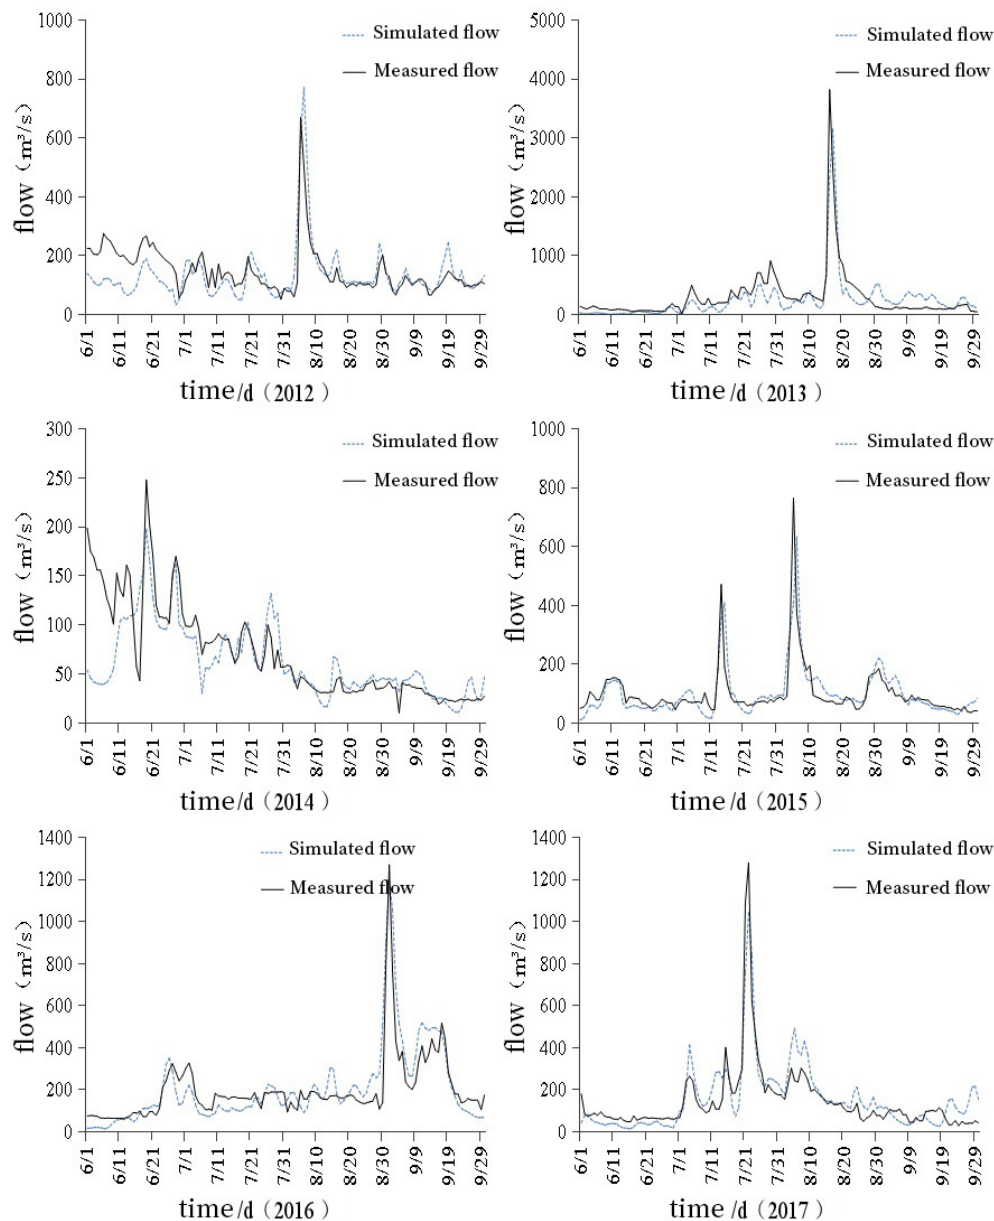
Figure 4. The simulation process of the runoff rate during the wet season and the verification period.